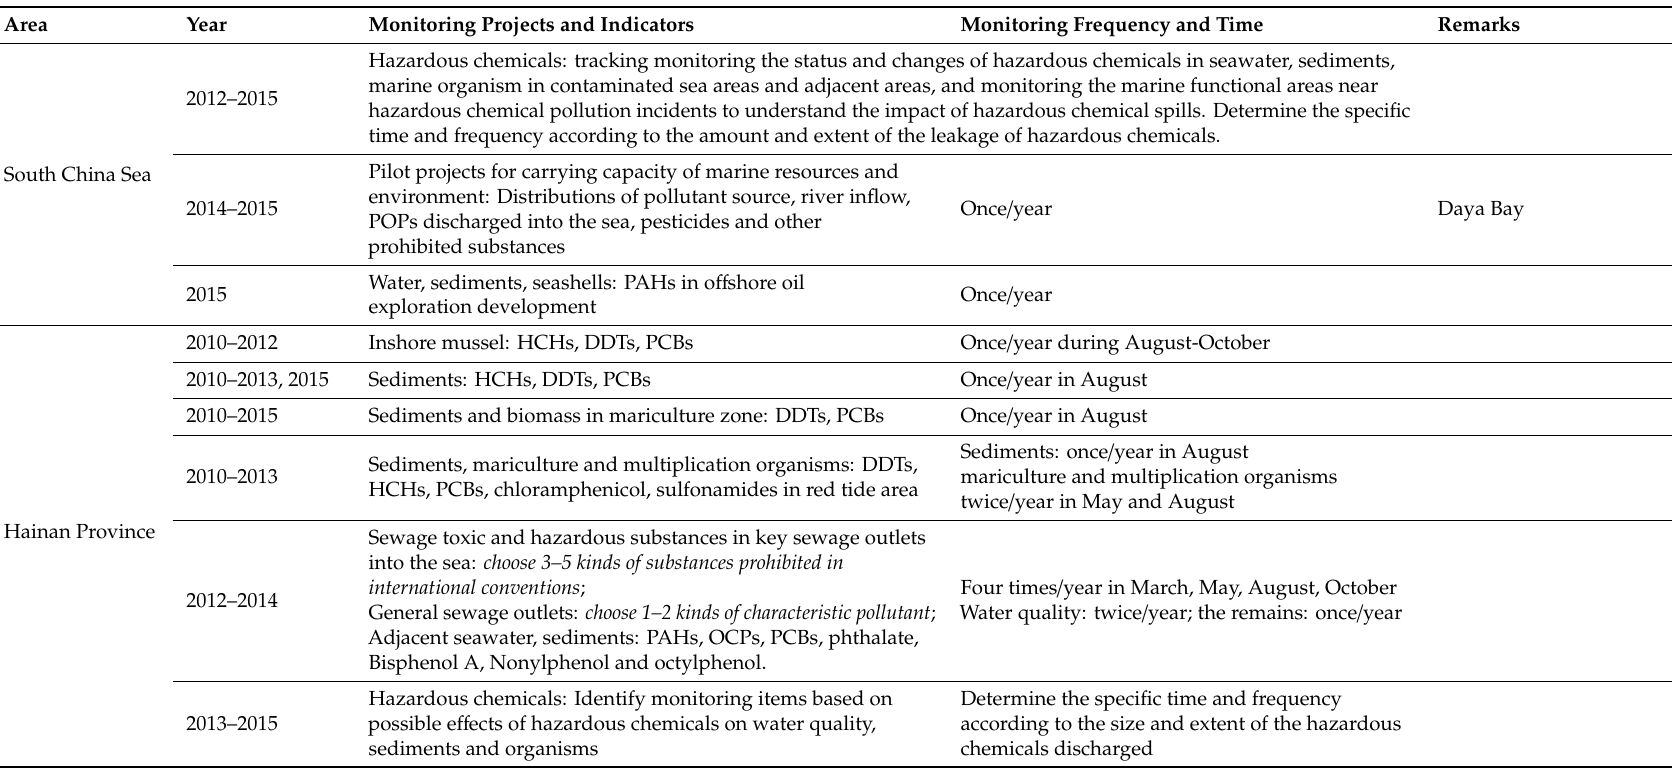
Table 2. Marine monitoring items including POPs in typical coastal provinces during “the 12th Five-Year” Plan of China.